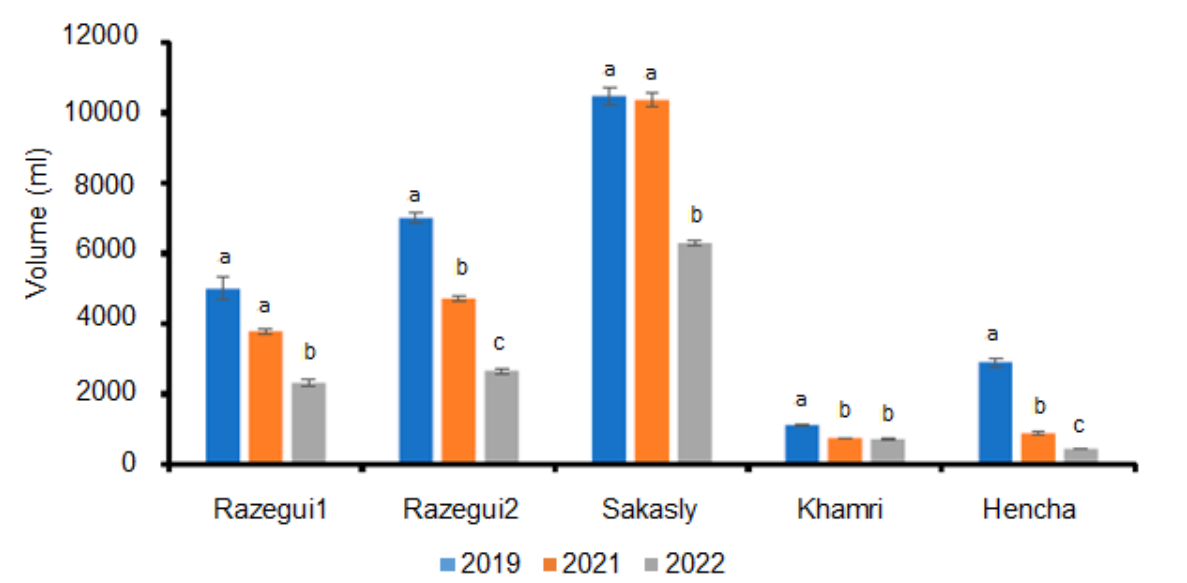
Figure 2. Comparison of the total xylem sap fluxes of five Tunisian grapevine cultivars measured during natural bleeding sap periods of 2019, 2021 and 2022. Different letters indicate significant differences among bleeding sap periods and cultivars and according to a repeated measures ANOVA ( p ≤ 0.05). Values are means ± SE.